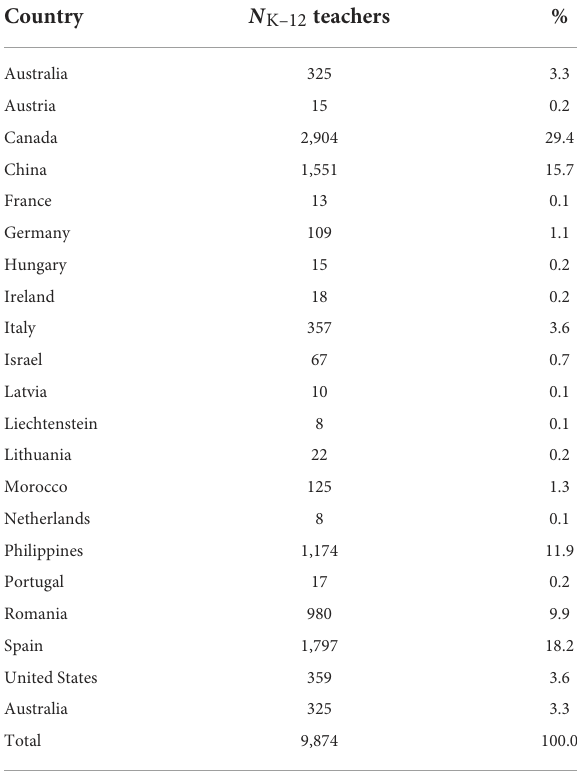
TABLE 5 K − 12 teachers samples broken down by